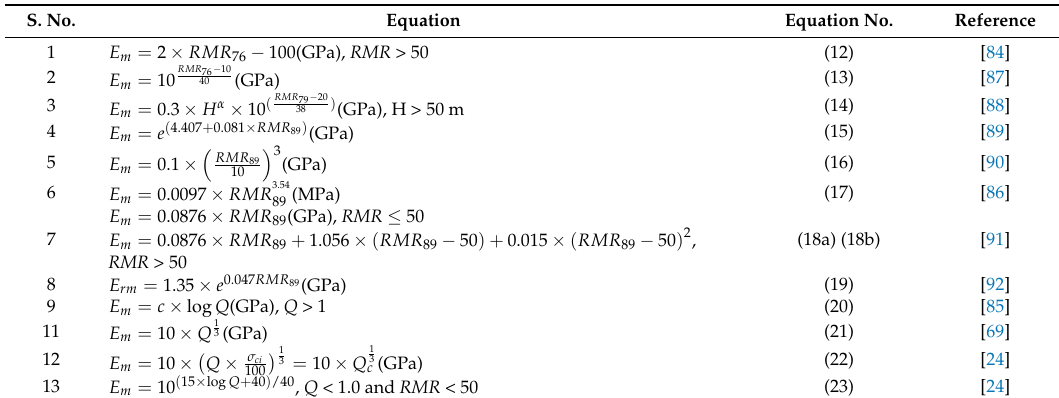
Table 4. Equations for calculation of E m without E i .